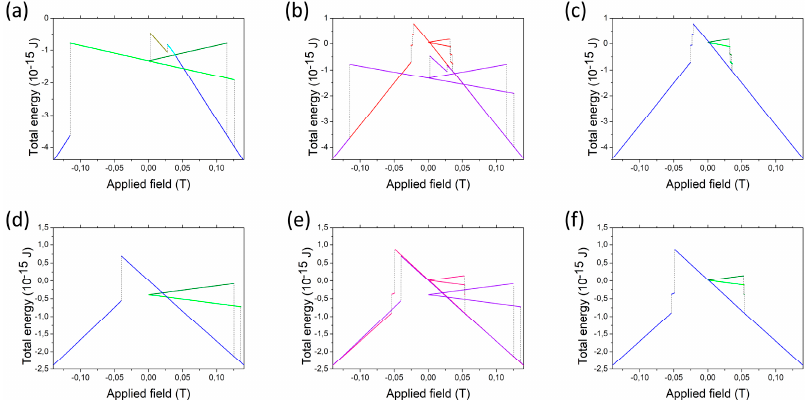
Figure 8. Energies of the subsequent configurations of the models of seven stripes and ellipsoids discussed in this section, upper panel: stripes, lower panel: ellipsoids. The leftmost ( a , d ) S-W model, the rightmost ( c , f ) micromagnetic calculations, the central parts ( b , e ) comparison of both.